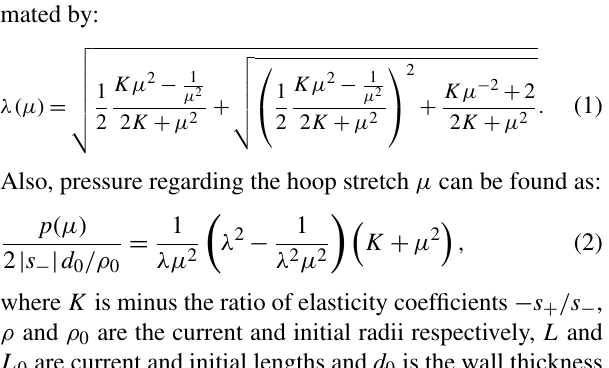
Figure 3. Navigation through obstacles is demonstrated. In re- gion 1, the lower balloon is inflated more in order to have a cur- vature to avoid lower obstacle. A similar procedure is followed in region